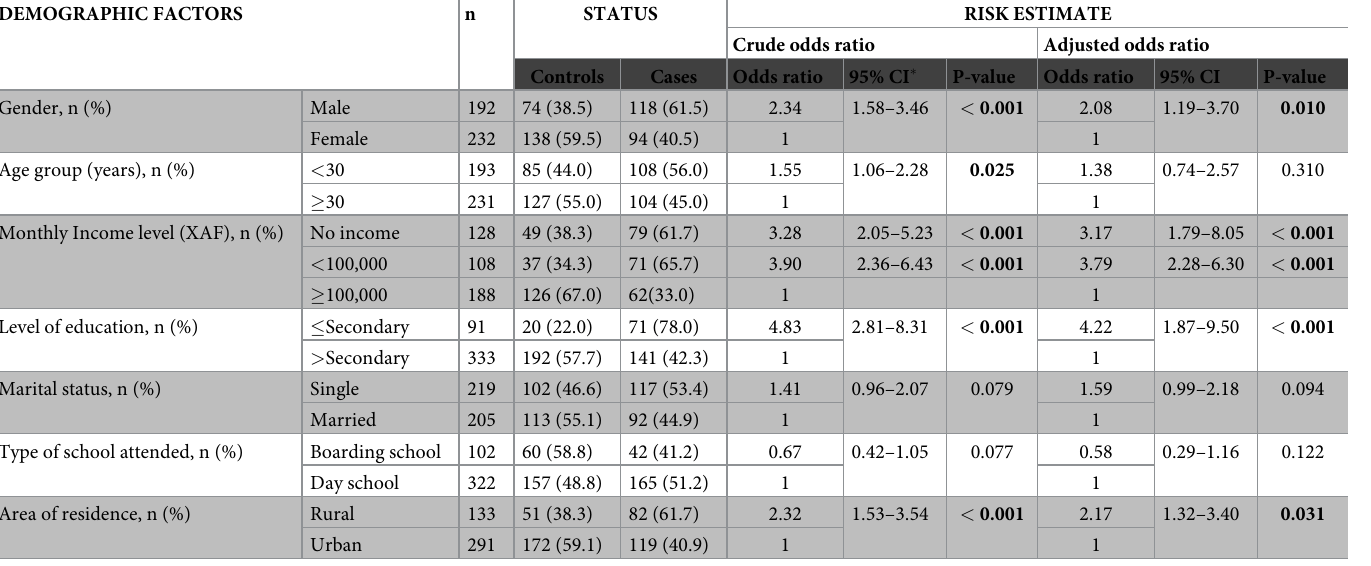
Table 2. Demographic factors and their possible association with HBV infection. DEMOGRAPHIC